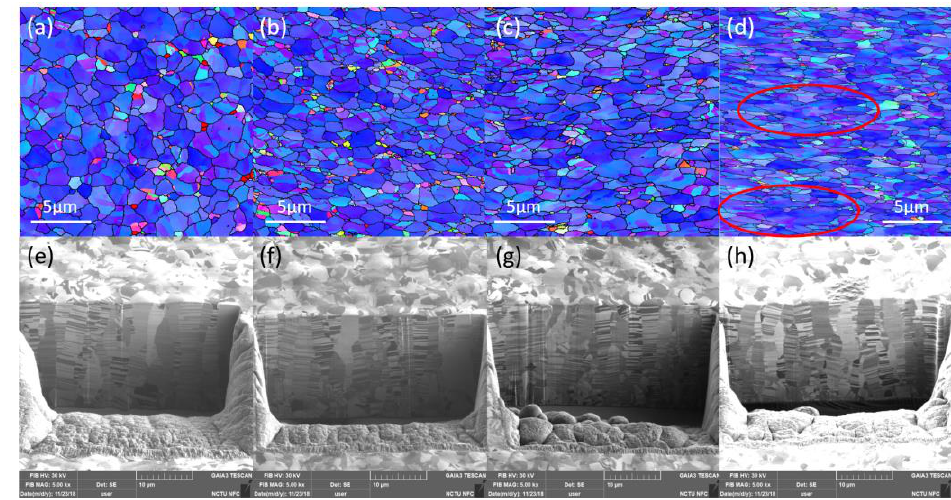
Figure 10. The top-view OIMs of the type-B nt-Cu at ( a ) ε x = 4%, ( b ) ε x = 11%, ( c ) ε x = 23%, and ( d ) ε x = 32%, where the ε x is defined as the strain along tensile direction. ( e ) to ( f ) are the correspond to cross-sectional ion images of the specimen in ( a ) to ( d ).